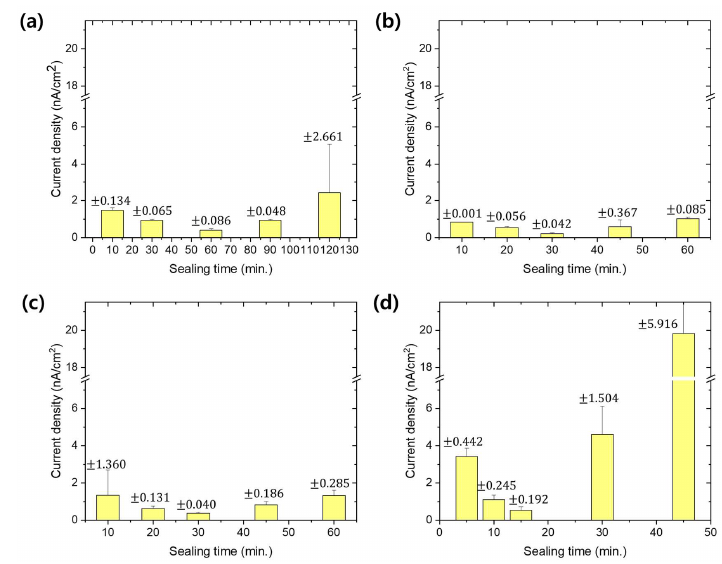
Figure 7. Estimated corrosion current density from potentiodynamic polarization curves (Figure 5) for anodized aluminum alloy with sealing in mixed solution ( a ) MSS1, ( b ) MSS2, ( c ) MSS3 and ( d ) MSS4 with respect to various treatment times.